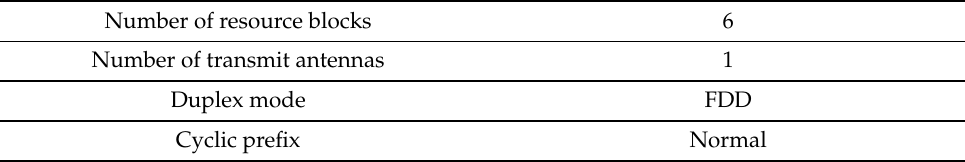
Table A3. The parameters for the physical downlink layer of